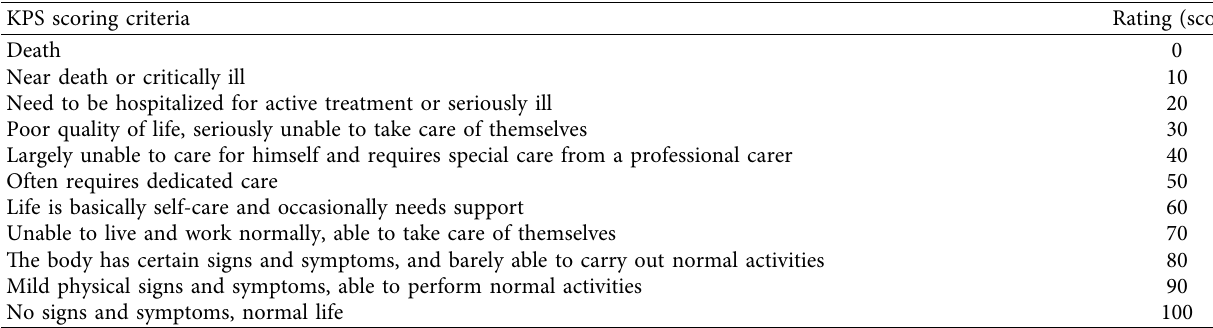
Table 2: KPS scoring criteria.